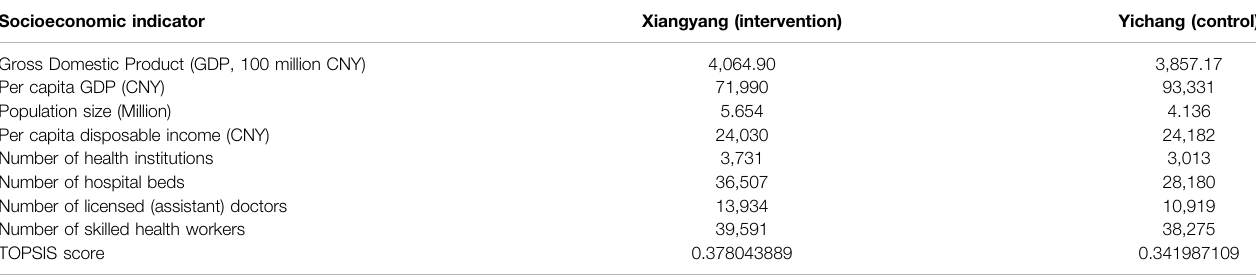
TABLE 1 | Socioeconomic characteristics of the two study municipalities in 2017. Socioeconomic indicator Gross Domestic Product (GDP, 100 million